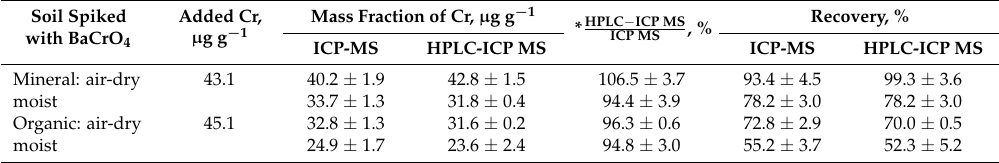
Table 5. The recovery and mass fraction of Cr(VI) extracted with Na 2 CO 3 from soil spiked with BaCrO 4